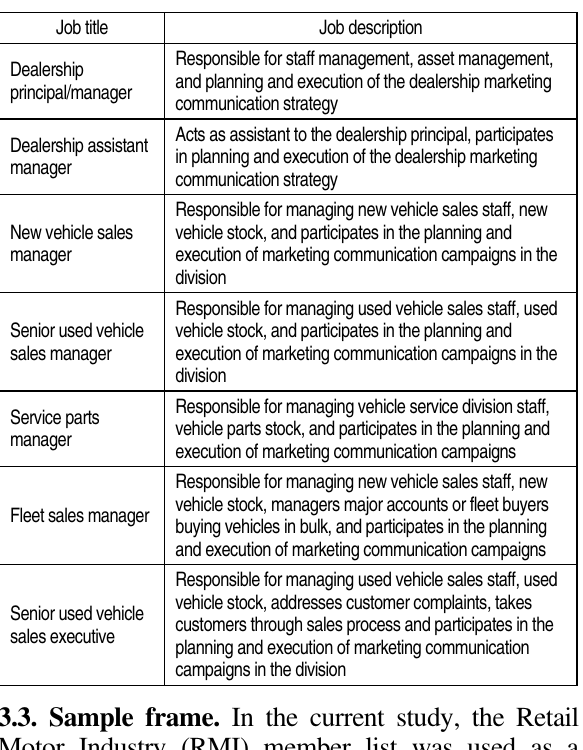
Table 1. Summary of the job descriptions